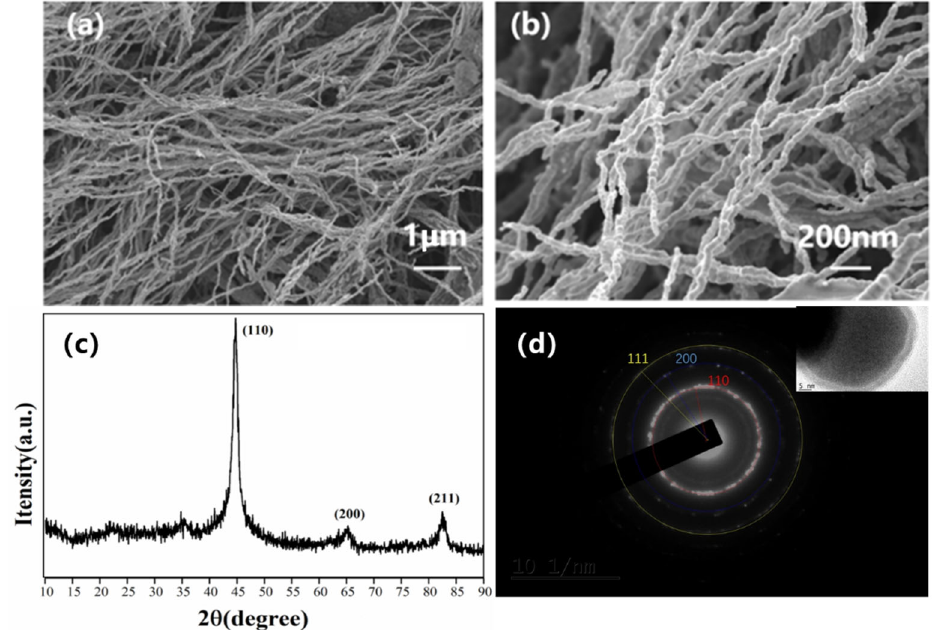
Figure 1. Characterization of Fe NWs: ( a , b ) remote and local SEM of Fe NWs, ( c ) XRD of Fe NWs, and ( d ) SAED of Fe NWs.